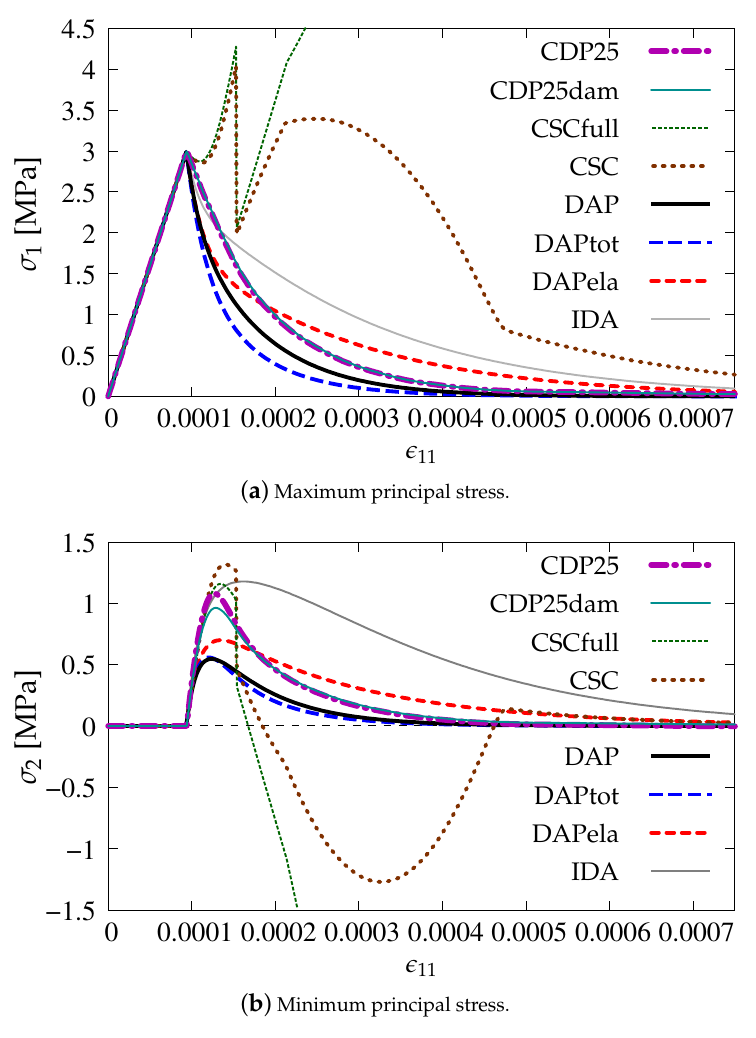
Figure 15. Comparison of models for principal